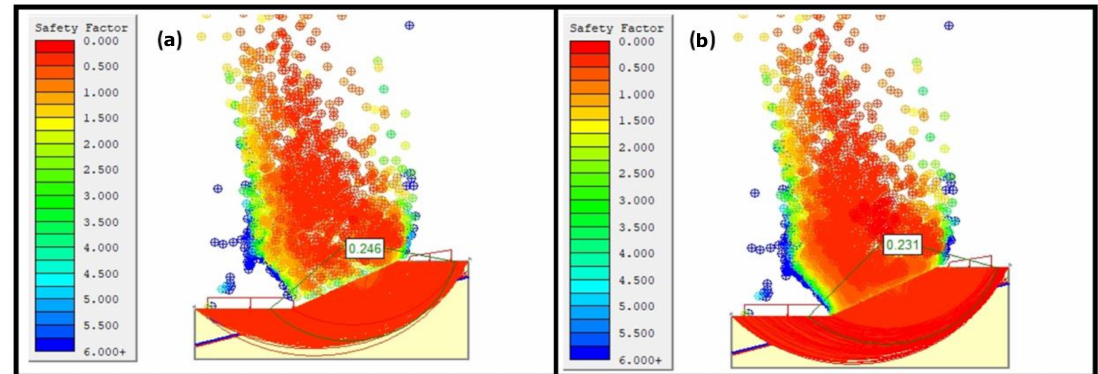
Figure 14. Safety factor simulated for rainy conditions in clay soil slope using ( a ) Lower Karafiath method and ( b ) the Gle / Morgenstern Price